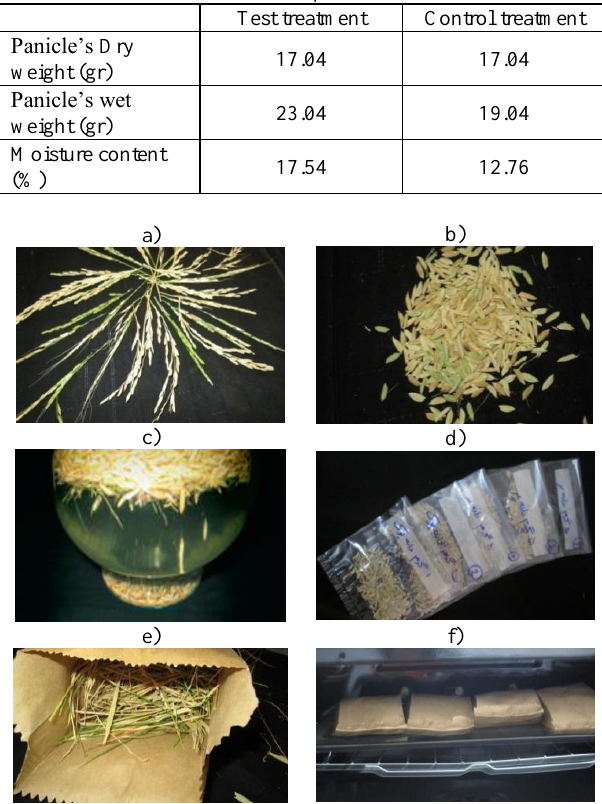
Table 5: Soil moisture content in paddies